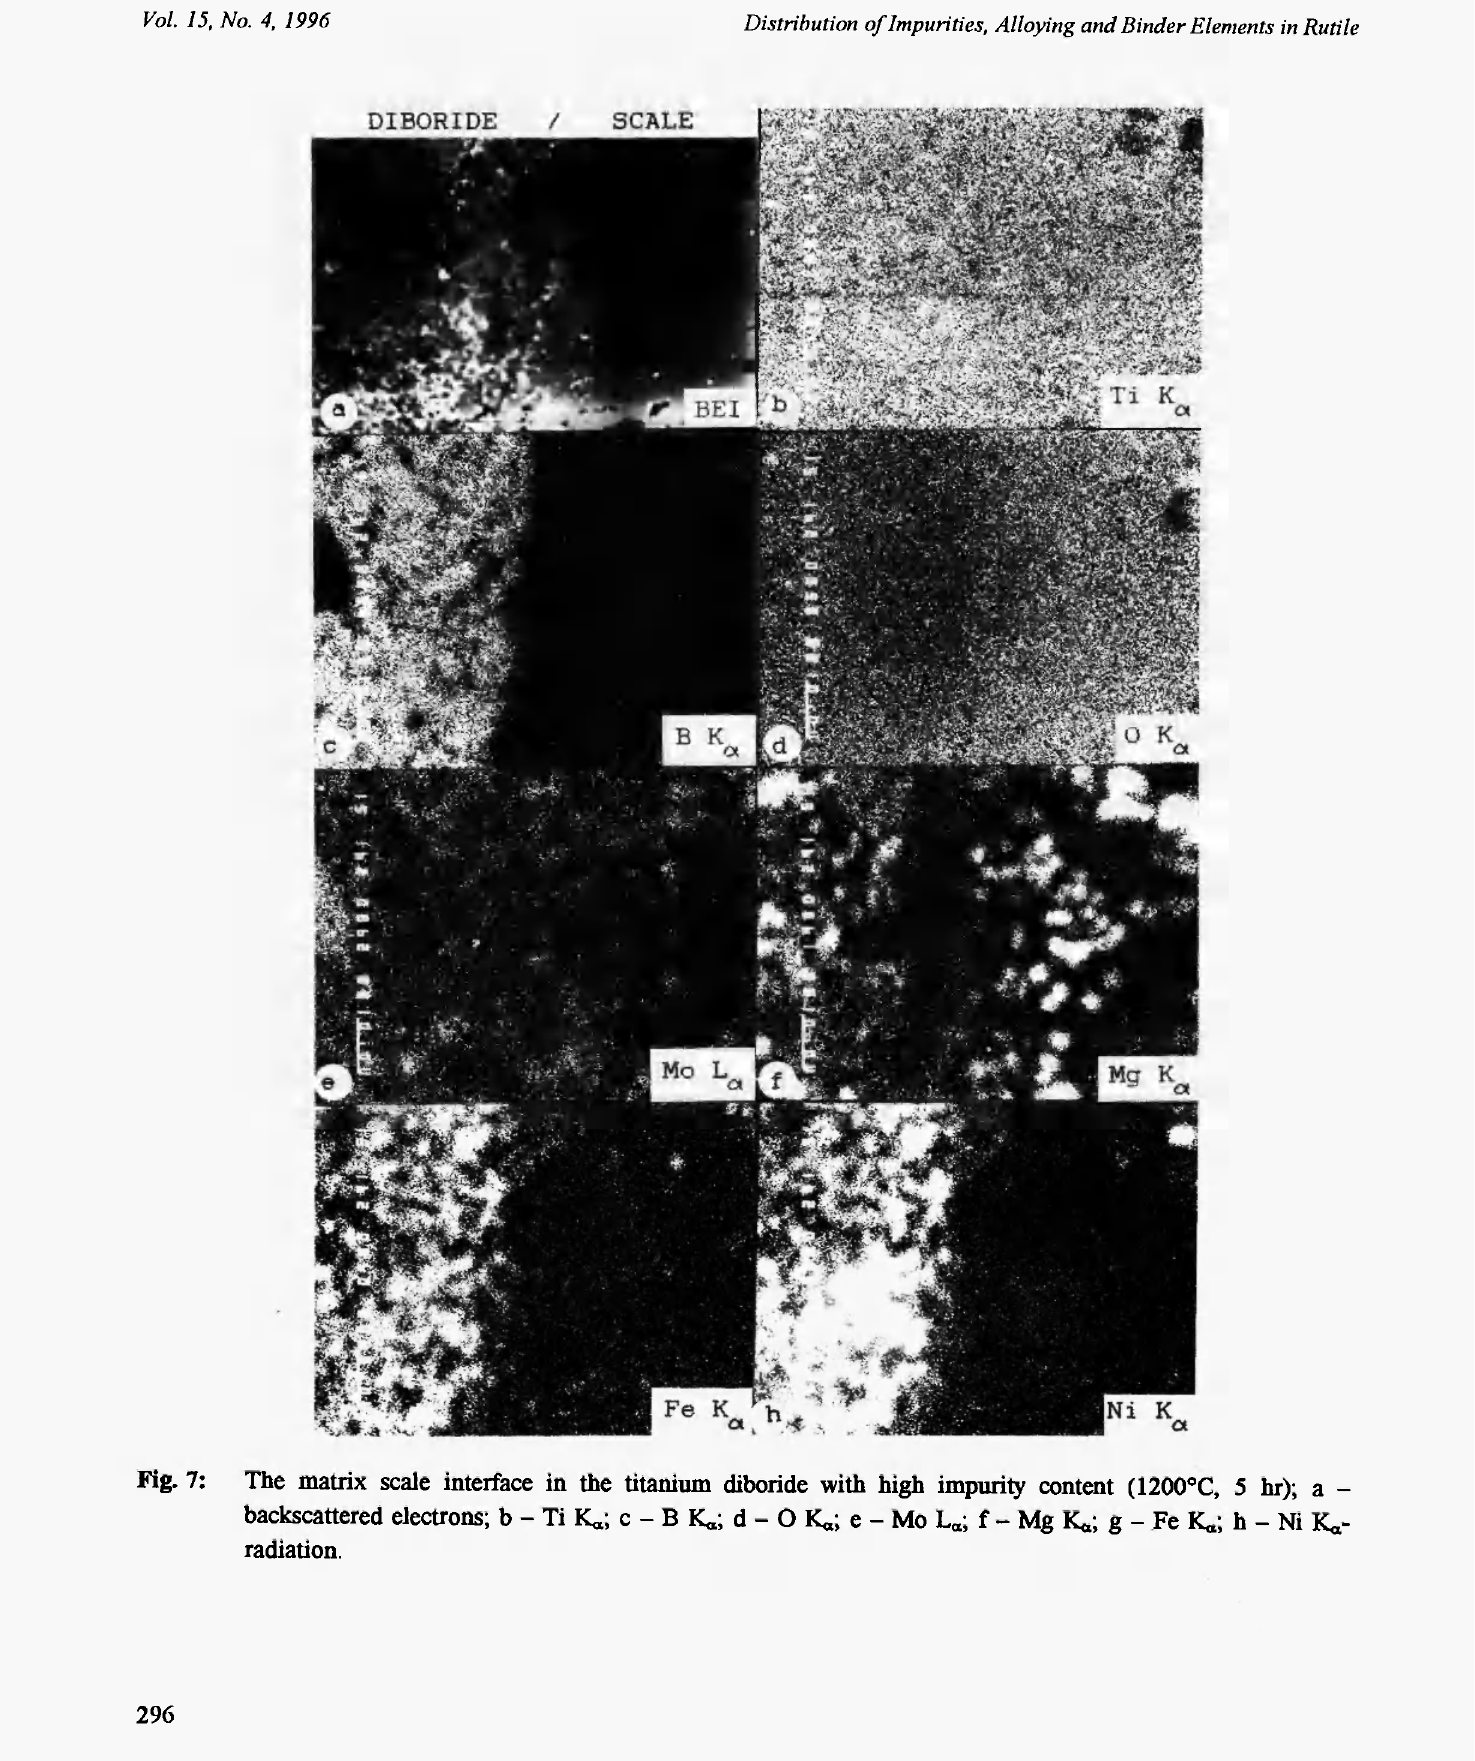
; f - Mg K^ g - Fe K«; h - Ni I r- a